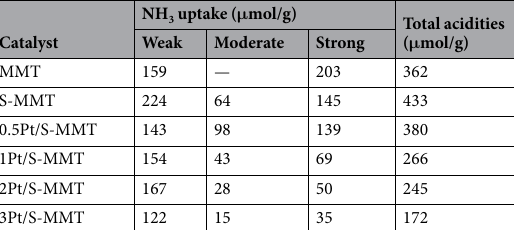
Table 1. Acidities of MMT, S-MMT and various Pt/S-MMT catalysts.